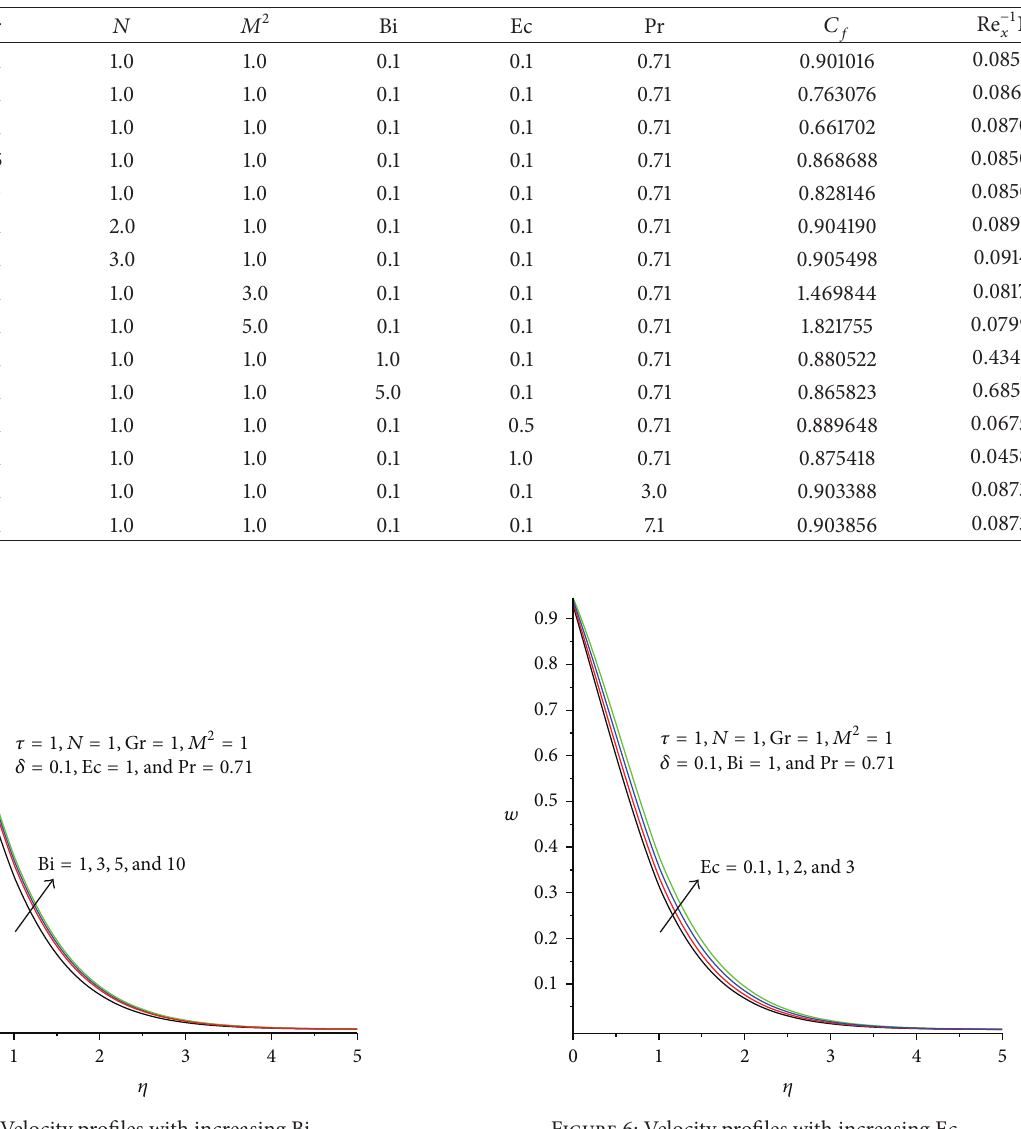
Figure 5: Velocity profiles with increasing Bi. Figure 6: Velocity profiles with increasing